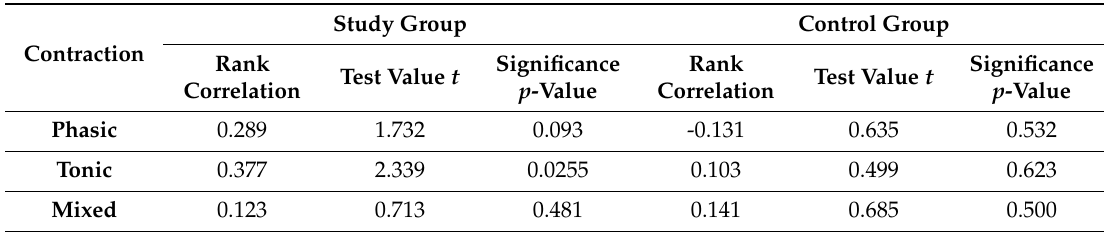
Table 10. Correlation between each type of contraction and the bruxism index in the study group and in the control group.